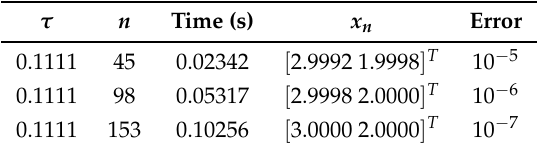
Table 2. x 0 = rand ( 2,1 ) , results with bounded perturbation.